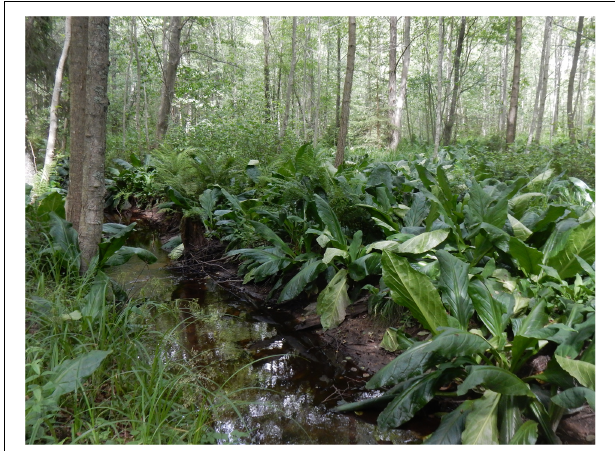
FIGURE 7 | American Skunk-cabbage ( Lysichiton americanus ) along Klokkarhyttebäcken, Sweden. Photo by Owe